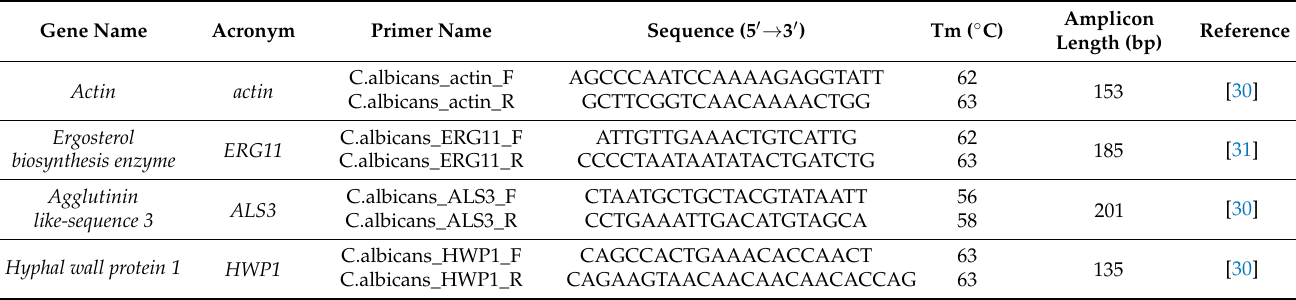
Table 1. Primer sequences used in this